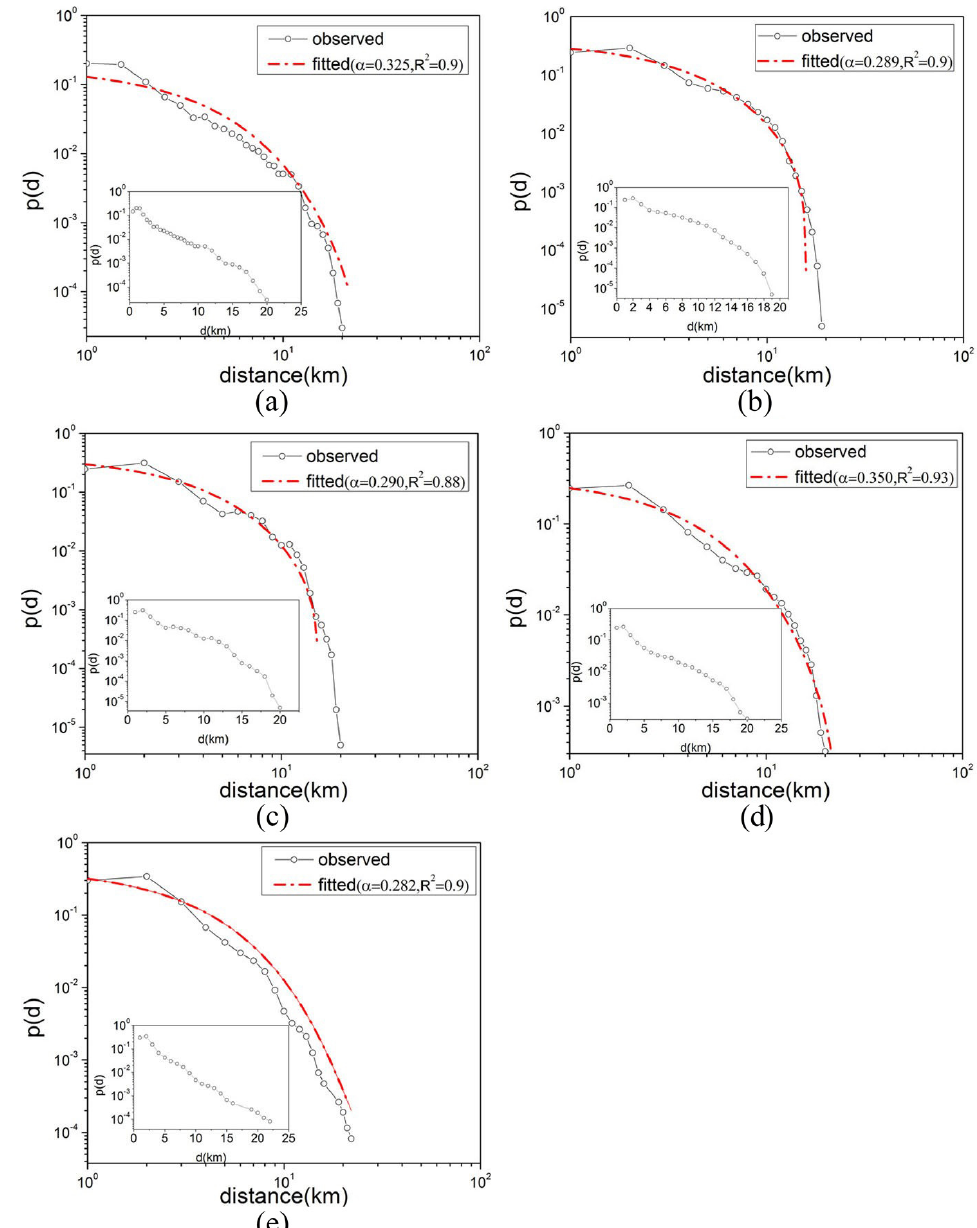
Figure 9. Distance distribution associated with each class of hospital. ( a – e ) represent the clusters of hospitals separately.